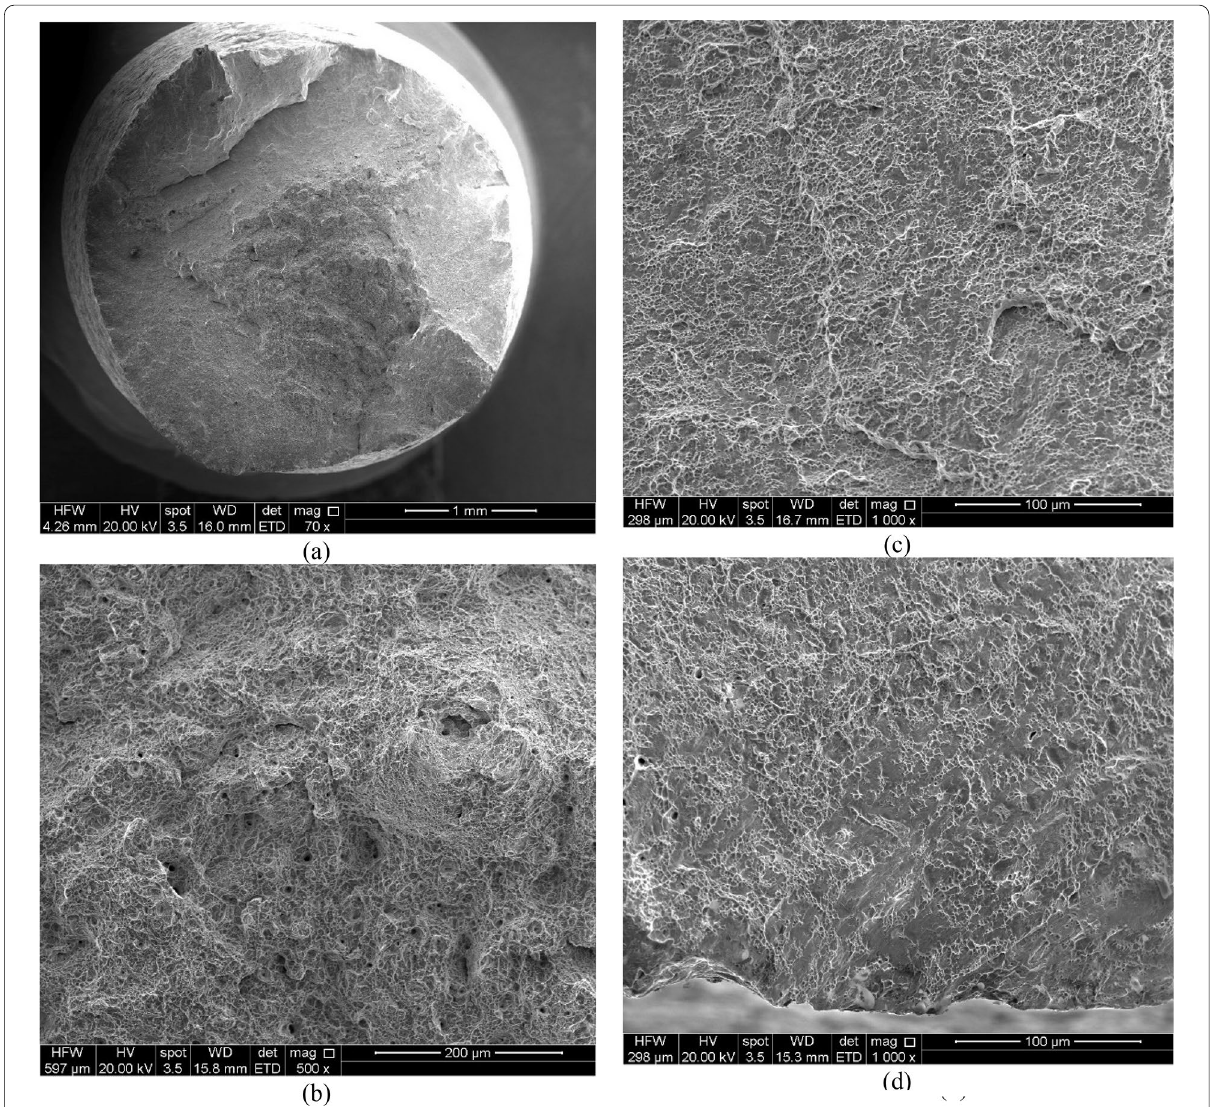
Figure 11 Tensile fracture morphology of the CuMn 13 Al 7 sample made by wire arc additive manufacturing: a fracture appearance, b fibrous zone, c radical zone, d shear lip